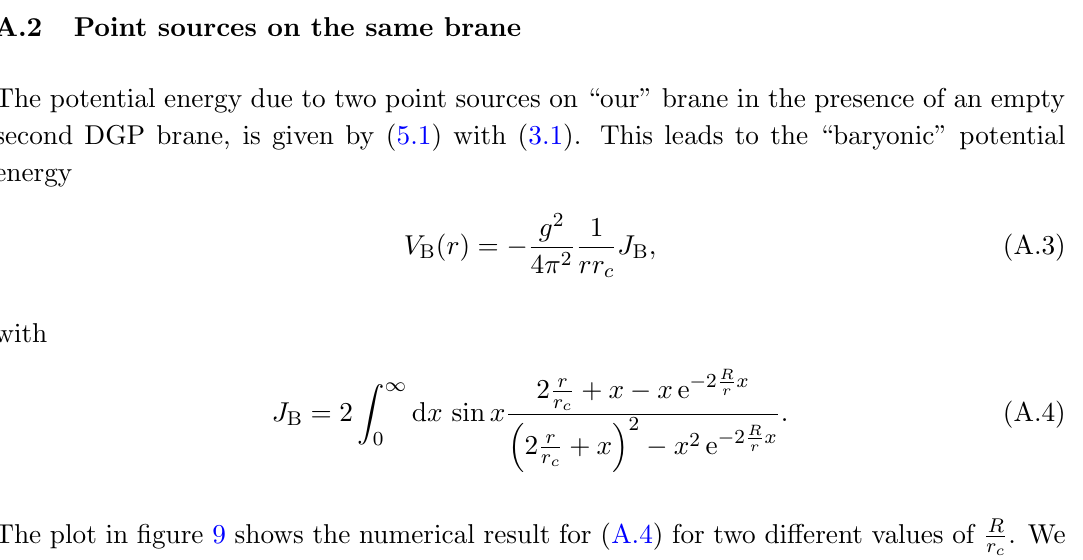
Figure 8. This log-log plot shows the numerical value of f (cid:0) 1 R ) for two di(cid:11)erent values of r c =R as solid curves. The blue curve is plotted for r c =R = 10 6 and the orange one for r c =R = 10 8 . The dashed curves are the functions 1 and 2 for r ! r c (with r and r c in units of R ), again for two di(cid:11)erent values of r c =R . We see (cid:25) rr c that the corrections given in (3.17) are good approximations for the numerical result, with 1 dominating for smaller r and 2 dominating for larger r , in the regime (I). The vertical lines show (cid:25) rr c the scales, which separate the regimes. We see that for larger r c =R the approximation gets